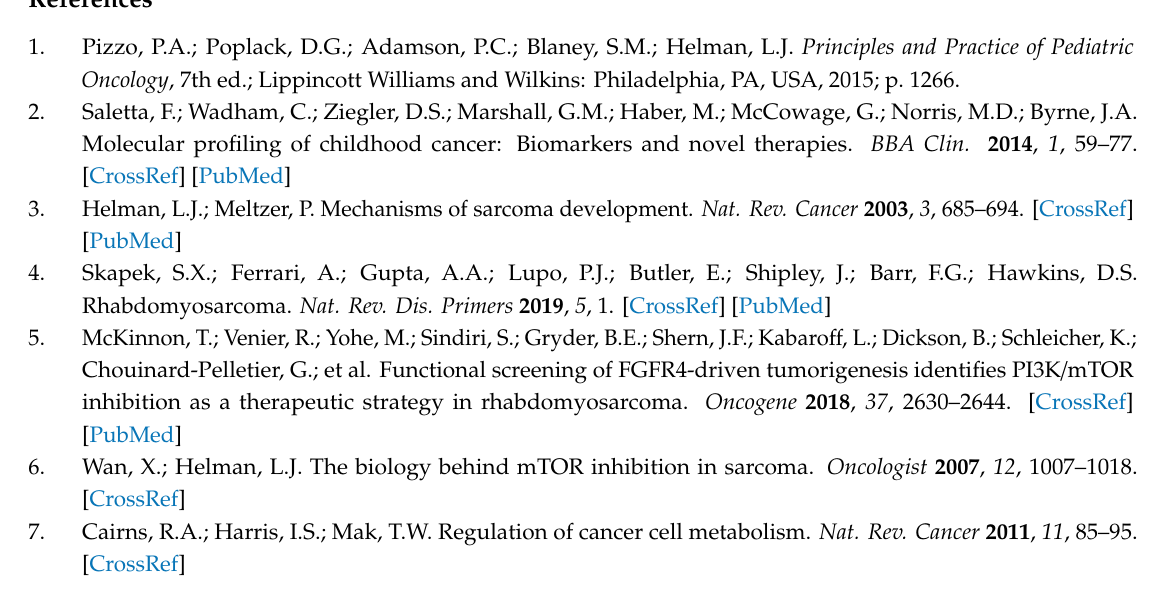
Table S1: The relevant clinicopathological characteristics of the studied patients, Table S2: The mean and median H-score results and the belonging probability values of the primary and recurrent samples according to PAX-FOXO fusion status, risk stratification and survival, Table S3: The immunopositivity and the statistical results of pmTOR, pS6, Rictor, PFKP, LDHA, G6PDH, ATPB and GLS stainings in the studied cases according to PAX-FOXO fusion status, risk stratification and